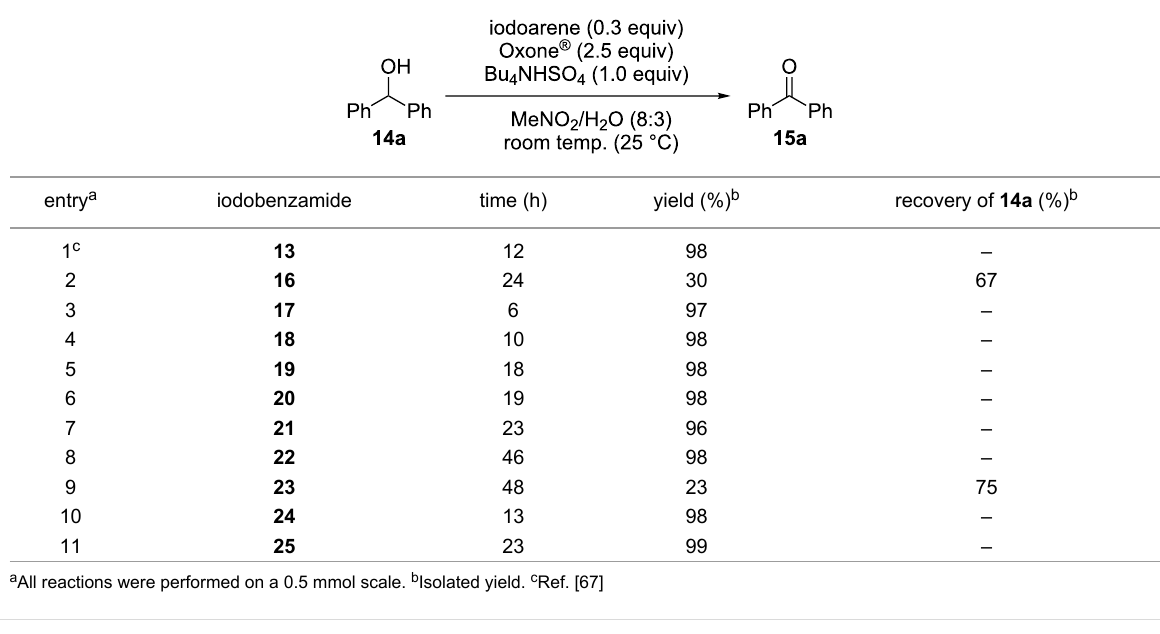
Table 1: Oxidation of benzhydrol ( 14a ) to benzophenone ( 15a ) catalyzed by 13 and 16 – 25 .